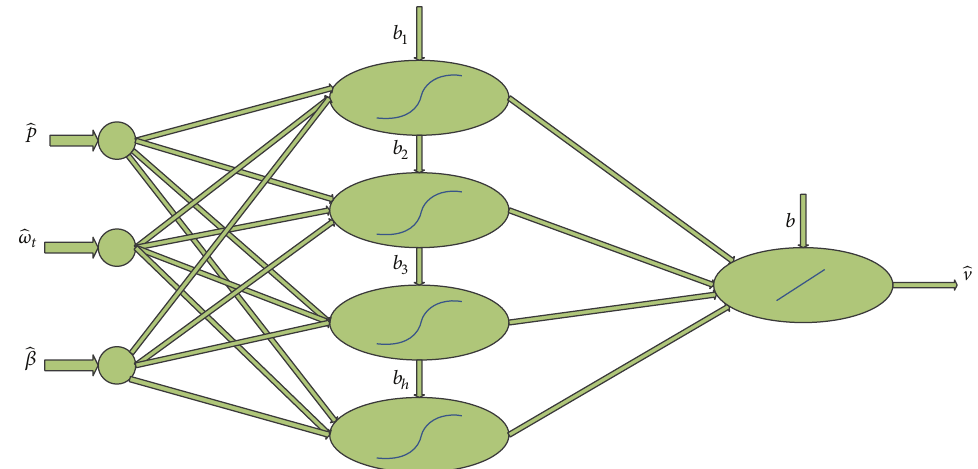
Figure 3: BPANN-based wind speed estimation